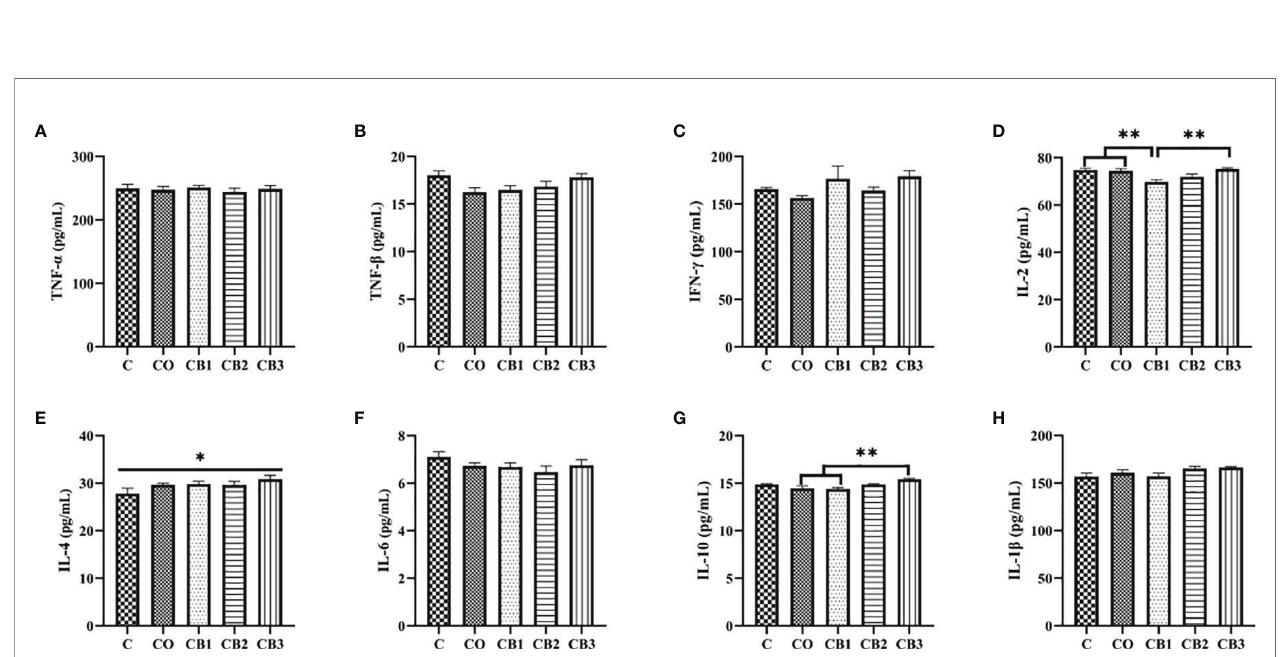
FIGURE 6 | Effects of dietary chitosan oligosaccharides (COS) and Clostridium butyricum synbiotic supplementation on in fl ammatory cytokines of jejunum in early- weaned pigeon squabs. (A) TNF- a , tumor necrosis factor alpha. (B) TNF- b , tumor necrosis factor beta. (C) IFN- g , gamma interferon. (D) IL-2, interleukin 2. (E) IL-4. (F) IL-6. (G) IL-10. (H) IL-1 b . Values are means with the SEM of eight squabs. * p < 0.05 and ** p < 0.01. C group, control group, squabs fed with arti fi cial crop milk; CO group, squabs fed with arti fi cial crop milk + 150 mg/kg COS; CB1, CB2, and CB3 group, squabs fed with arti fi cial crop milk + 150 mg/kg COS + 200, 300, and 400 mg/kg C. butyricum ,